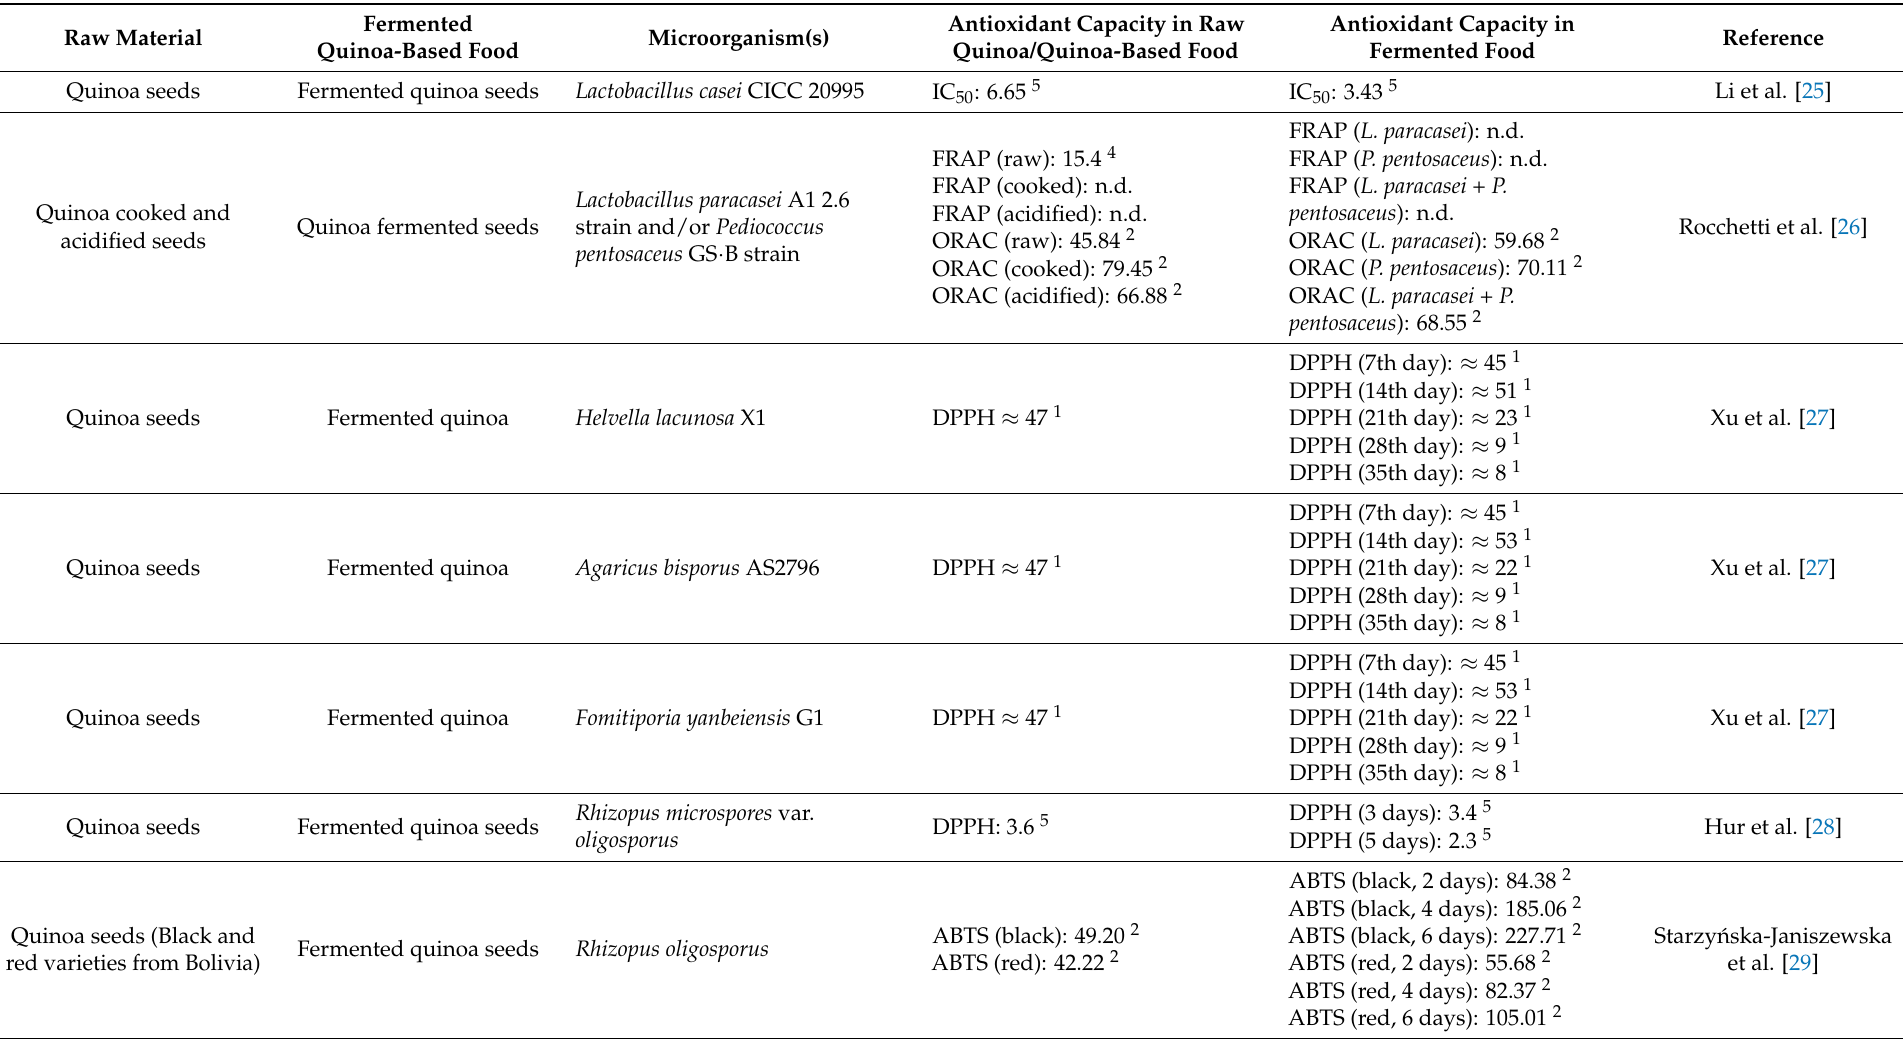
Table 3. Effect of fermentation on antioxidant capacity in quinoa-based fermented